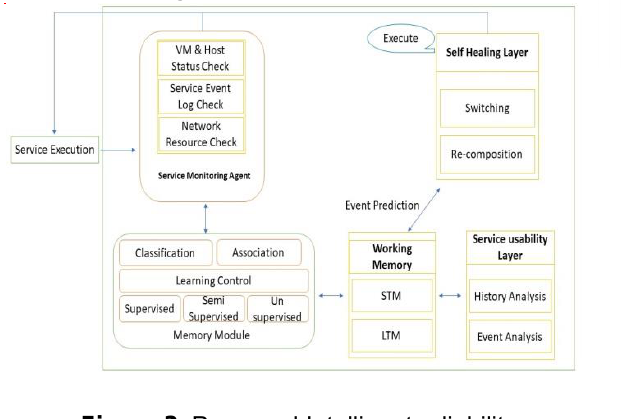
Figure 3. Proposed Intelligent reliability